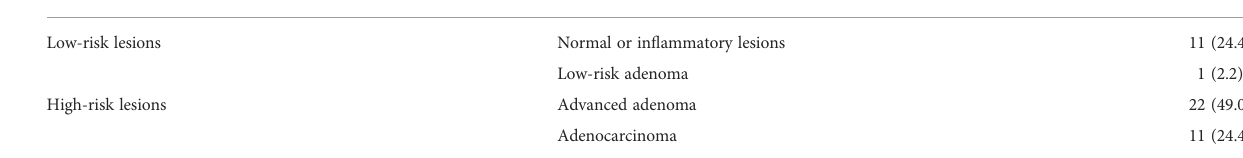
TABLE 2 Actual lesions found by colonoscopy ( n =45).